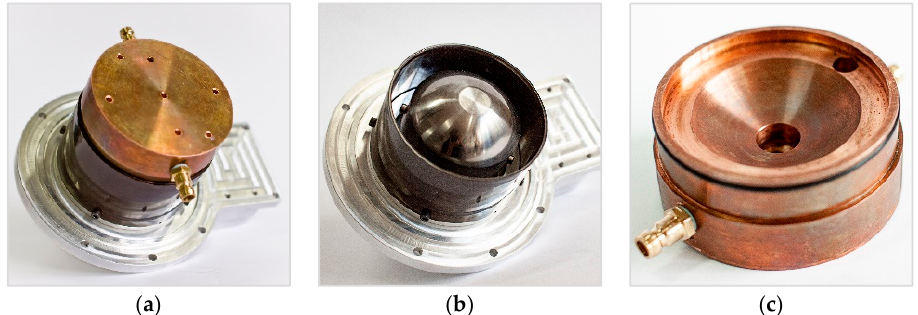
Figure 15. Machining cell: ( a ) prepared to work, ( b ) workpiece, ( c ) working electrode. Detailed dimensions of the electrodes are shown in the drawing (Figure